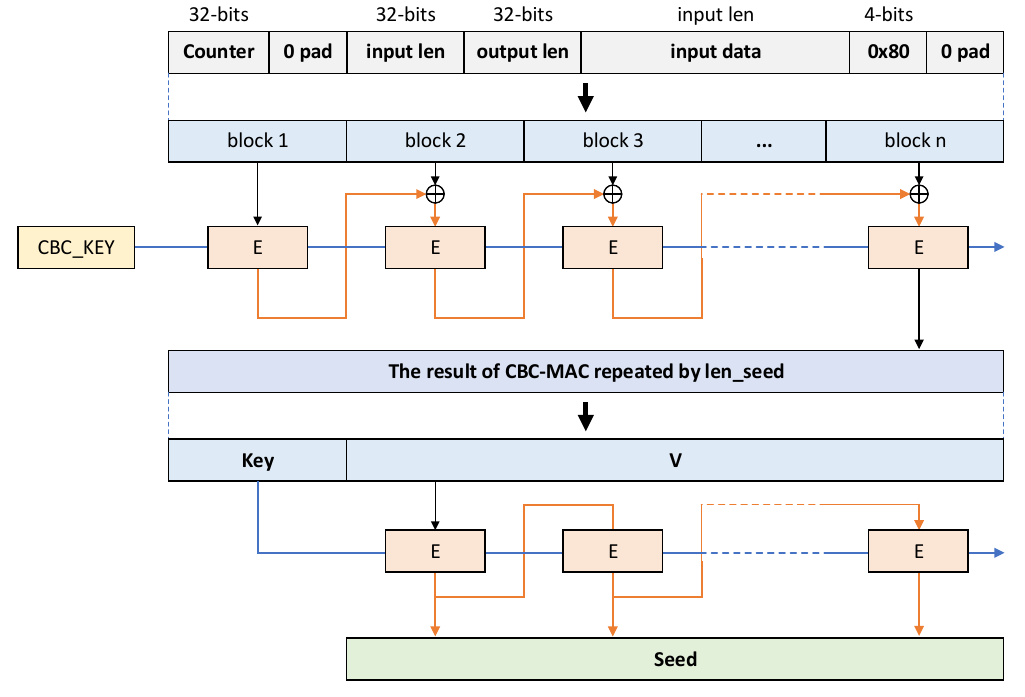
Figure 5. Derivation